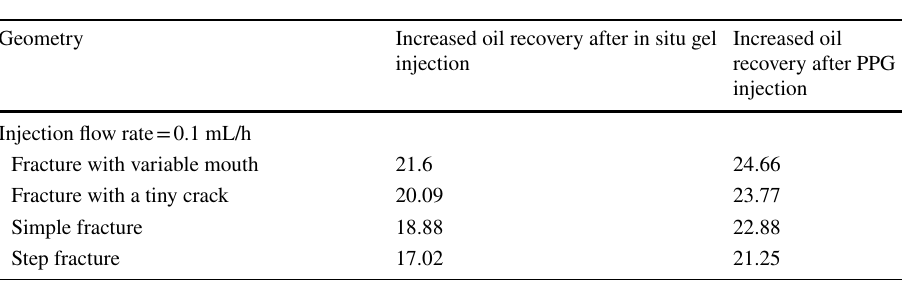
recovery after injecting gel into the